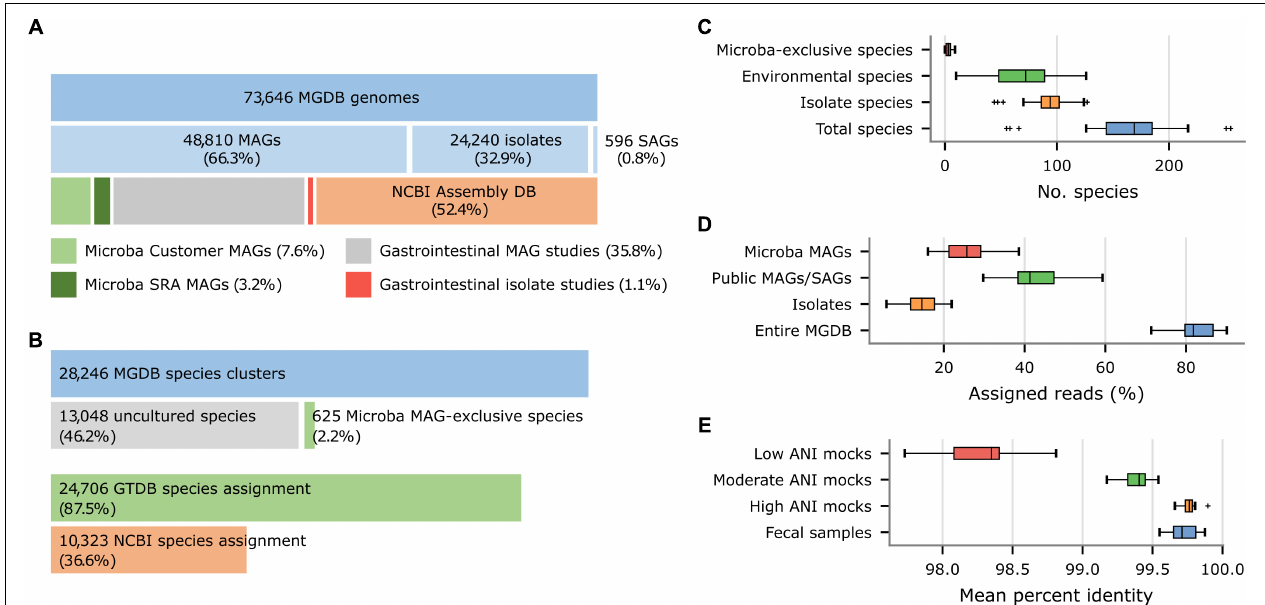
FIGURE 5 | Properties of the Microba Genome Database (MGDB) and the results of profiling 33 US fecal samples using the MCP with the MGDB as a reference database. (A) Proportion of MAGs, isolates, and SAGs within the 73,646 genomes comprising the MGDB along with the source of these genome assemblies. Gastrointestinal MAGs were recovered from the studies of Almeida et al. (2019), Nayfach et al. (2019), and Pasolli et al. (2019) and gastrointestinal isolates from the studies of Forster et al. (2019) and Zou et al. (2019). (B) Proportion of the 28,246 MGDB species clusters comprised exclusively of uncultured genomes (i.e., MAGs or single-amplified genomes) obtained from multiple sources or solely of MAGs recovered by Microba. This is followed by the proportion of MGDB species clusters that can be assigned a GTDB or NCBI species assignment. (C) Total number of species reported by the MCP for each sample and the number of these species which are uncultured species or Microba MAG-exclusive species. (D) Total percentage of reads assigned by the MCP to genomes in the MGDB and the percentage assigned to isolates, public MAGs/SAGs, or MAGs obtained by Microba. (E) Percent identity of reads mapped by the MCP for 33 US fecal samples and in silico mock communities with decreasing ANI similarity to genomes in the standardized reference